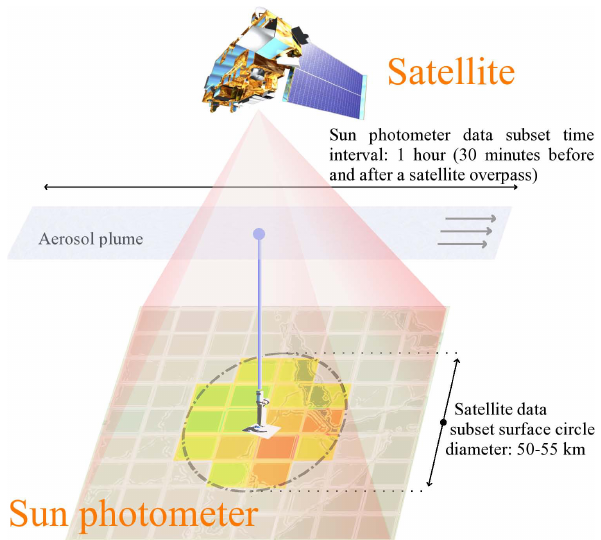
Fig. 1. Overview of the sampling framework used in MAPSS. Sam- pling of each spatial spaceborne aerosol product involves extract- ing values of the pixels that fall within an approximate radius of 27.5km from the chosen locations. Similarly, ground-based tempo- ral observations in a particular location are sampled from measure- ments taken within 30min before and 30min after a satellite passes over this location.